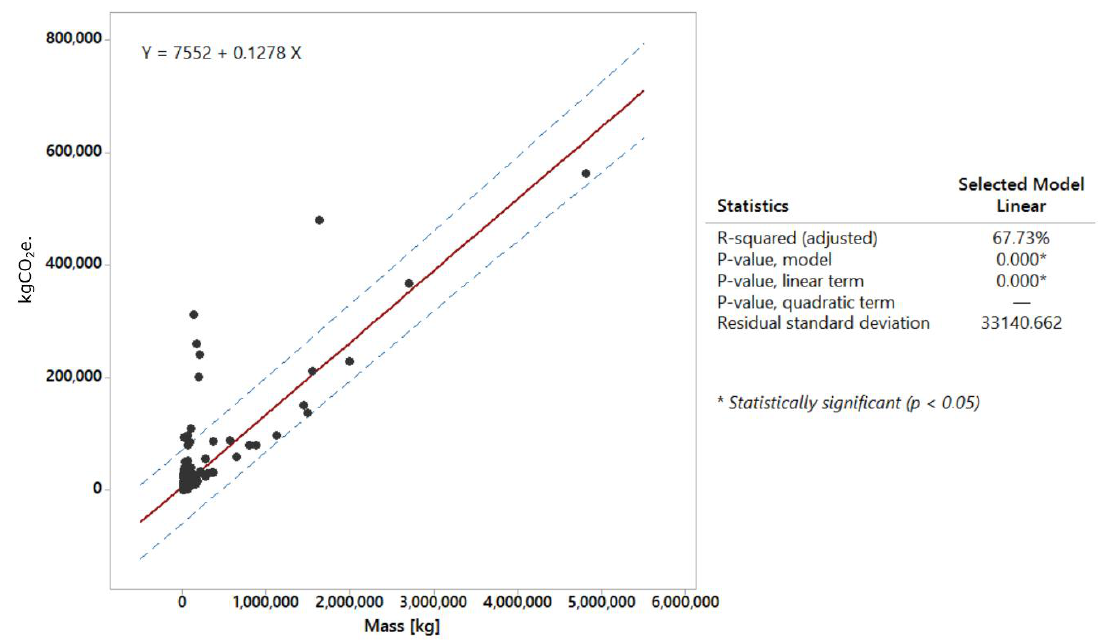
Figure 5. The weight of all inventory items plotted against emissions from material production (A1– A3) in kgCO 2 e., together with a regression model of the correlation. One outlier which is related to a special case of ground reinforcement was